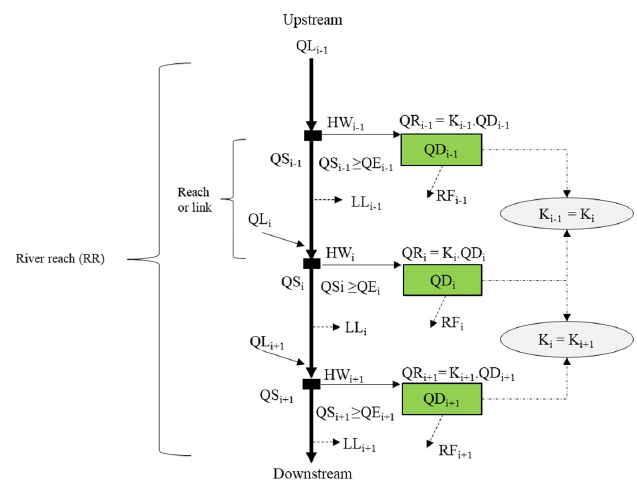
Figure 5. Variable in network-flow node trajectory.